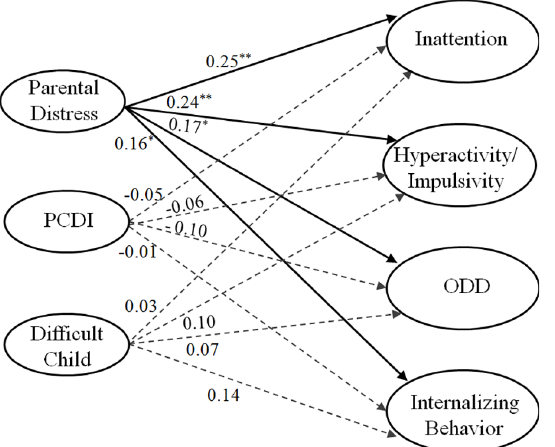
Fig 1. Model of effectsof parenting stressfactors and informant discrepancies on symptoms of ADHD/ODD and internalizing behaviors. PCDI denotesparent-child dysfunctional interaction; ODD denotesoppositional defiant disorder. a Note : ParentalDistress, parent-childdysfunctional interaction,and Difficult Childare associatedwith one another; Inattention, Hyperactivity/Impulsivity, ODD, and internalizing behaviors are associatedwith one another. b Note : Inattention, hyperactivity/impulsivity, Oppositionaldefiant, and internalizing behaviorsare all standardized difference scores (SDS).